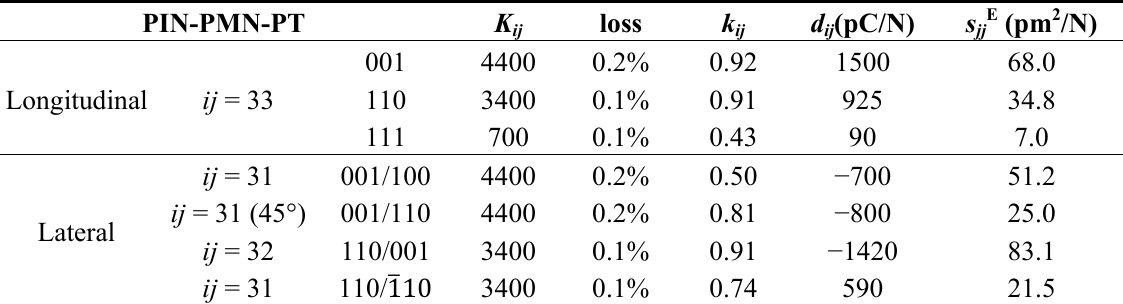
Table 4. Longitudinal and transverse piezoelectric and electromechanical properties for <001>-, <110>- and <111>-poled PIN-PMN-PT